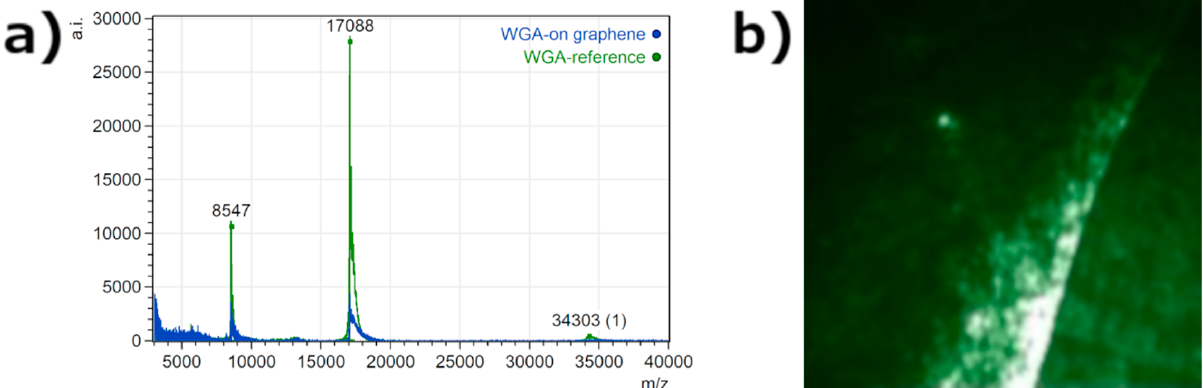
Figure 4. ( a ) MALDI spectra overlaying the reference spectrum of WGA (green), and the spectrum acquired on functionalized graphene after incubation with WGA (blue). The dominant masses in both spectra are 8.5, 17.1, and 34.3 kDa. ( b ) Fluorescence imaging of a graphene edge functionalized with GlcNAc after incubation with fluorescently labeled (fluorescein isothiocyanate, FITC) WGA. A clear contrast is observed at the edge of functionalized